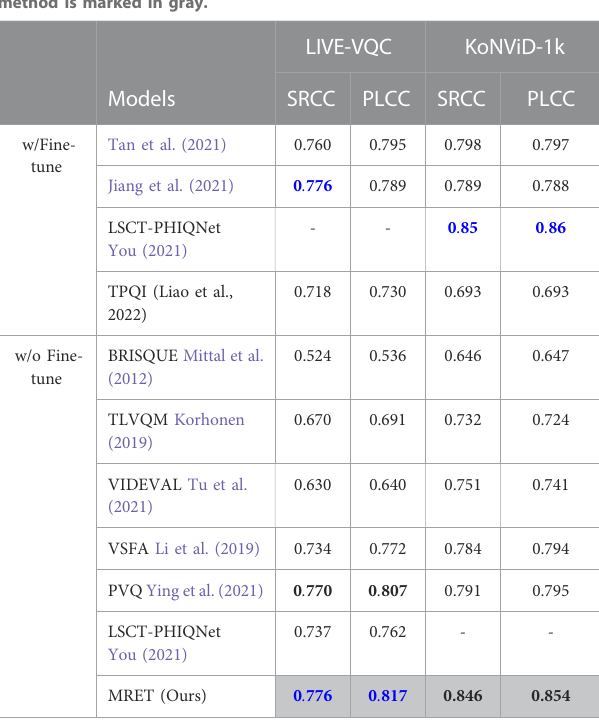
TABLE 2 Performance on KoNViD-1k and LIVE-VQC. Methods except LSCT- PHIQNet (You, 2021) in “ w/o Fine-tune ” group are trained on LSVQ. Blue and black numbers in bold represent the best and second best respectively. We take numbers from (Ying et al., 2021; Jiang et al., 2021; You, 2021; Tan et al., 2021; Liao et al., 2022) for the results of the reference methods. Our fi nal method is marked in